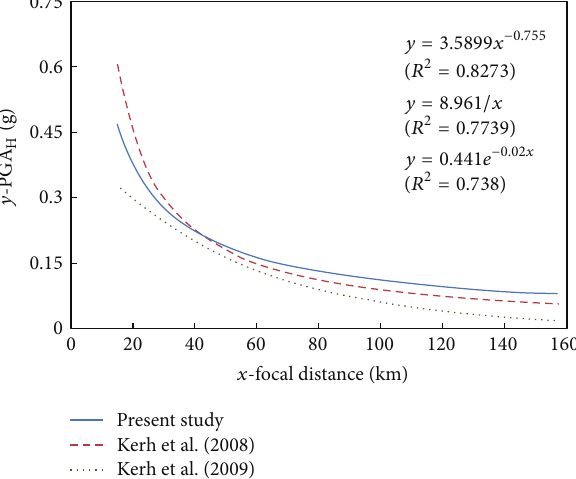
Figure 10: Curve fitting model for horizontal PGA and focal